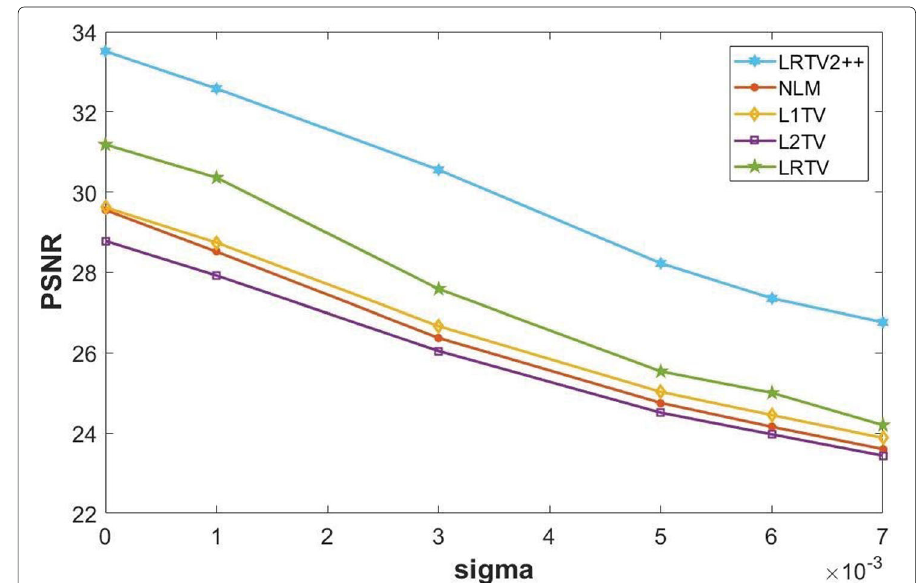
Fig. 1 PSNR of different methods with increasing noise variance from 0.001 to 0.007